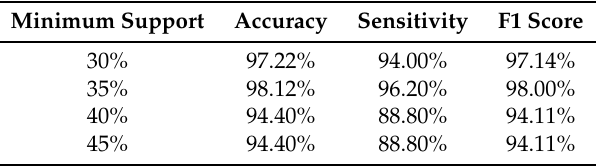
Table 7. Classification results at the end of